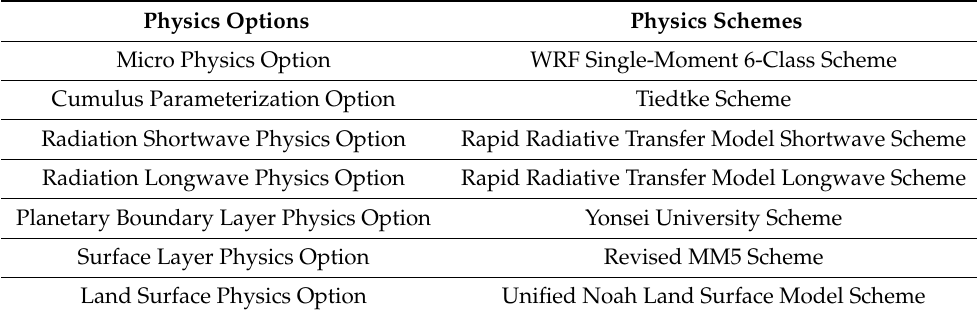
Figure 6. Experimental domain. d02 denotes the initial position of the vortex center for the typhoon moving-nested run. Table 1. Summary of the used physics